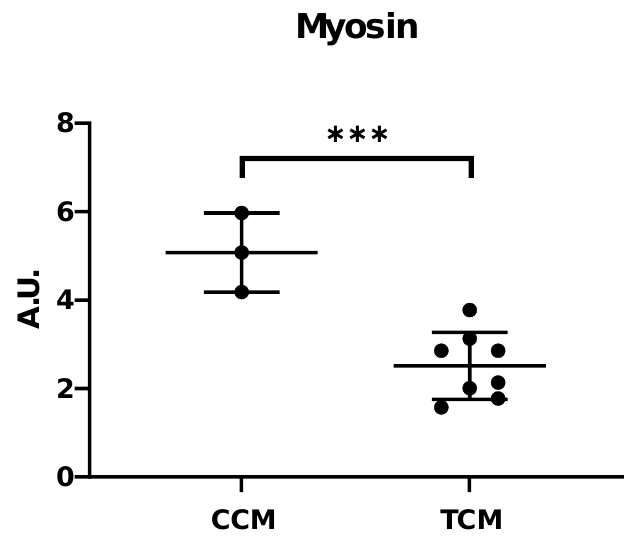
Figure 2. Myosin expression (heavy chain) in human primary myotubes incubated with either tumor conditioned media or control conditioned media. Mean ± SD of (heavy-chain) myosin expression levels in myotubes incubated with either tumor-conditioned media (TCM) (n = 3) or control-conditioned media (CCM) (n = 3, two tumor cell lines). ***: p < 0.001. AU: absorbance unit. The uncropped blots and molecular weight markers are shown in Supplementary Figure S2.